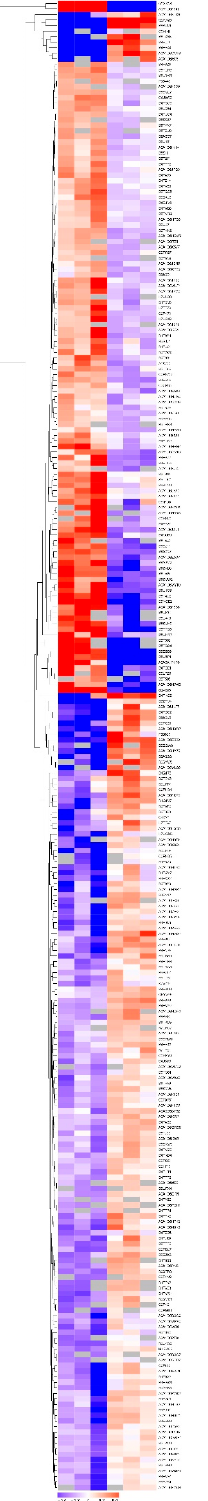
Figure 4. Clustering analysis of differentially abundant proteins (DAPs) in SD_TD comparison. Each row represents a protein significantly abundantly expressed. First three columns refer to technical replicates (MD1–3) for MO17 drought stressed, whilst the last three columns (8D1–3) refer to replicates for YE8112 drought stressed. The scale bar on the X -axis indicates the logarithmic value (log 2) expression of the DAPs, up-regulated (red) and down-regulated (blue).